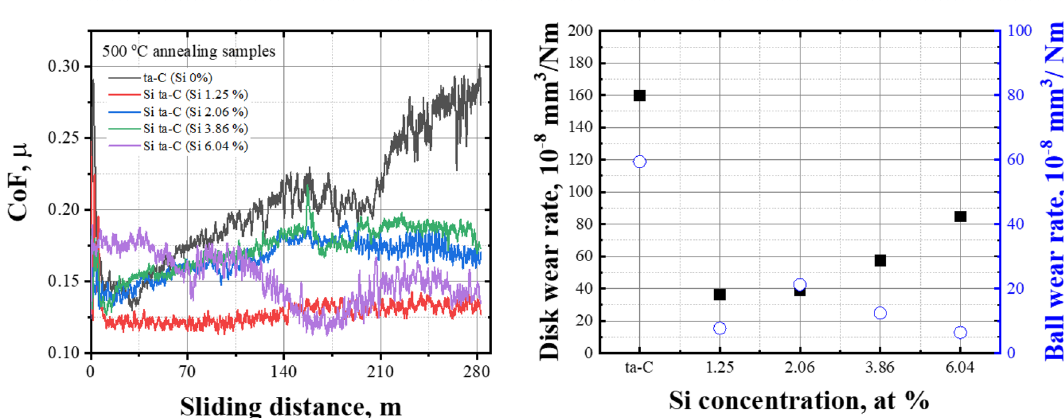
Figure 13. Coefficient of friction (CoF) and disk and Si 3 N 4 ball wear rate of tetrahedral amorphous carbon (ta- C) and Si/SiC/ta-C composite (Si–ta-C) coatings after annealing at 500